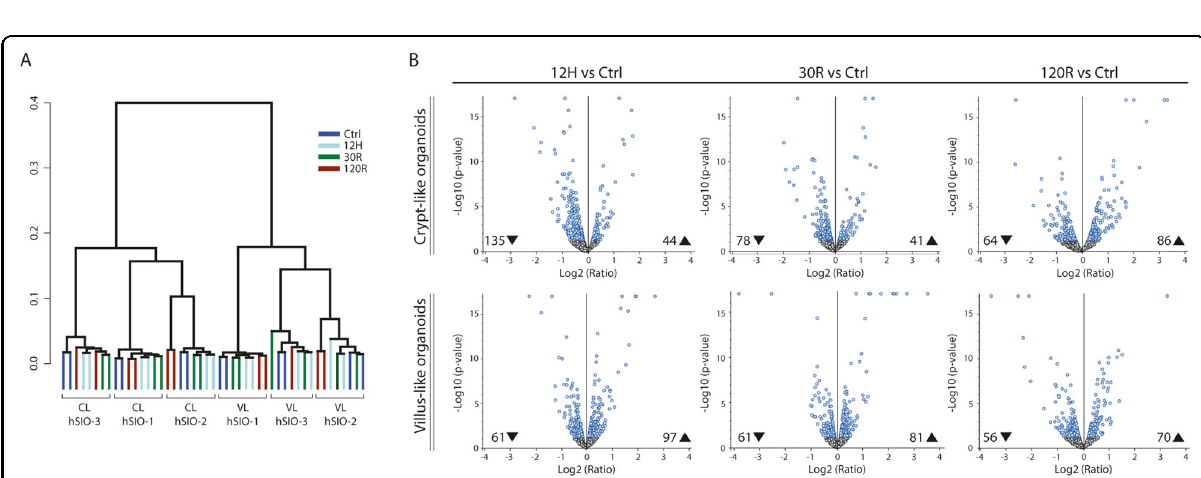
Fig. 2 Proteomics analysis of the response to hypoxia – reoxygenation. A Hierarchical clustering of the complete proteomics dataset. 12H 12 h of hypoxia, 30 R 30 min of reoxygenation, 120 R 120 min of reoxygenation. B Volcano plots for experimental conditions 12H, 30R, and 120R compared to Ctrl in crypt-like and villus-like hSIOs, in which abundance ratio (Log2) is plotted against the p -value ( − log10). The number upregulated ( ▲ ) and downregulated ( ▼ ) proteins are indicated in every plot (adjusted p -value < 0.05). On/off proteins are not shown and can be found in Table S2. N = 6 from 3 hSIO